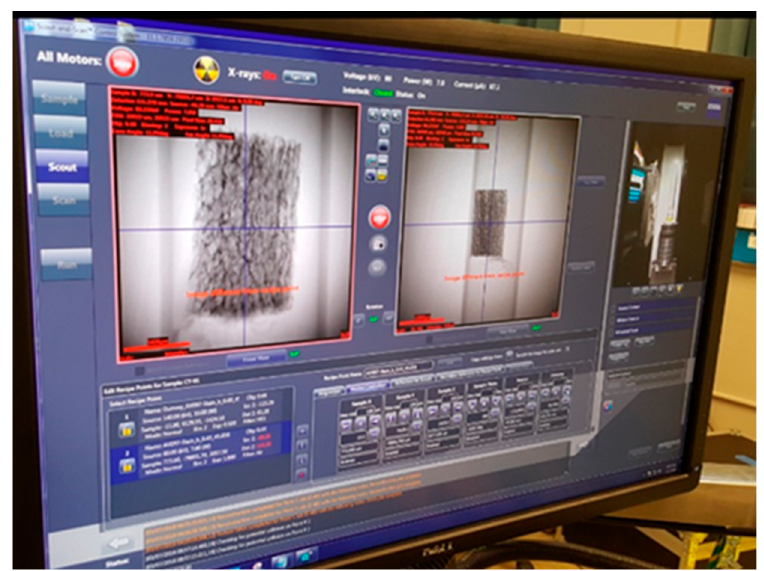
Figure 3. Tuning the Scanning Parameters. Table 1. Setting of the used Micro-CT Scanner.